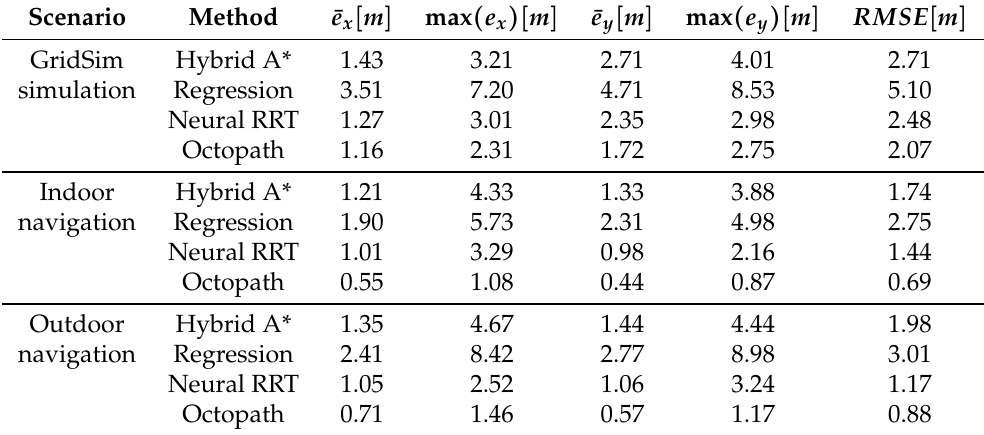
Table 1. Errors between estimated and ground truth trajectories in simulation and real-world navigation testing